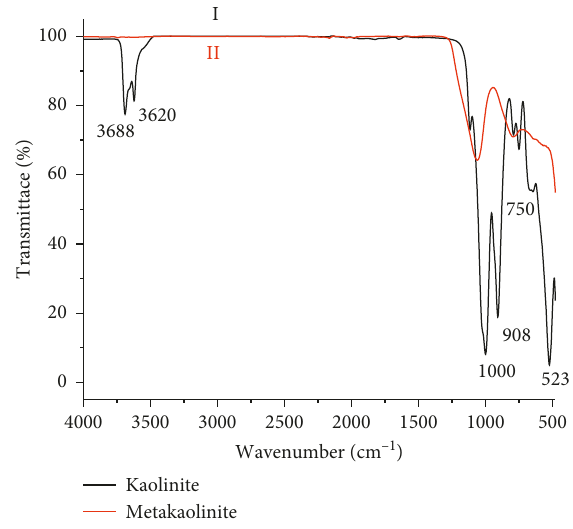
Figure 4: FTIR curves of kaolinite and